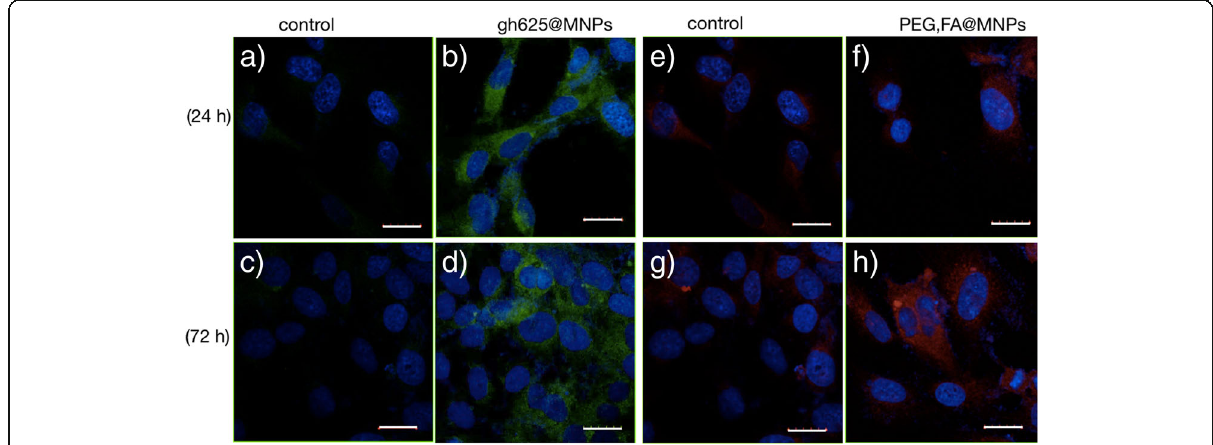
Fig. 7 LSM fluorescence micrographs of HBMEC. LSM fluorescence micrographs of HBMEC incubated for 24 h ( b , f ) and 72 h ( d , h ) with NBD-labelled gH625@MNPs 15 μ g/ml ( b , d ) and their controls ( a , c ) or rhod-labeled PEG,FA@MNPs 15 μ g/ml ( f , h ) and their controls ( e , g ). Scale bar = 20 μ